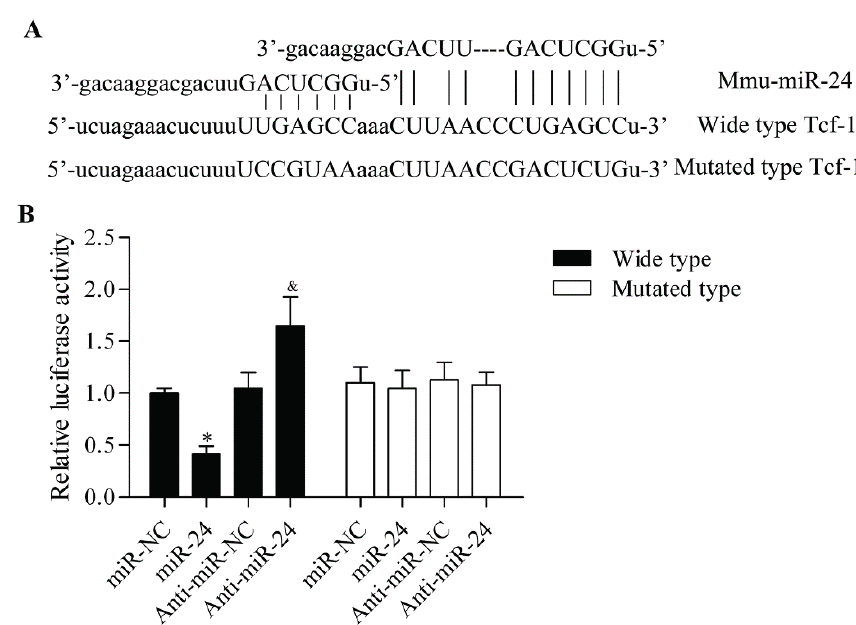
Figure 4. miR-24 directly targets the 3'-UTR of Tcf-1. ( A ) The 3'-UTR of Tcf-1 had the putative binding sites with miR-24; ( B ) The direct binding relationship between 3'-UTR of Tcf-1 and miR-24 was detected by a dual luciferase activity assay. The wild type or mutated 3'-UTR of Tcf-1containing the putative binding sites for miR-24 in pGL3 luciferase reporters was transfected into MC3T3-E1cells cells with miR-24 or anti-miR-24. After 48 h of incubation, cells were harvested and luciferase activity was measured by the dual luciferase reporter assay system. N = 6, * p < 0.05 vs. miR-NC; and & p < 0.05 vs.